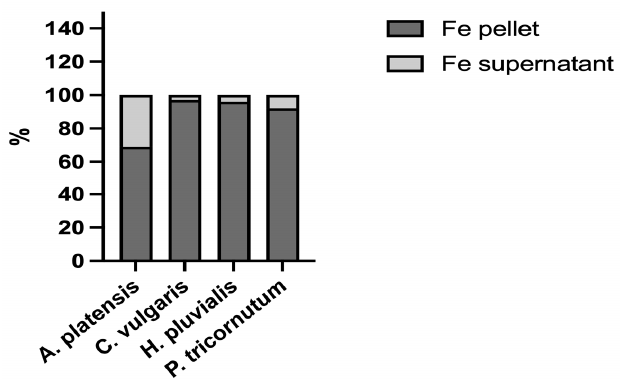
Figure 2. Iron distribution between the supernatants (soluble fractions) and pellets (insoluble frac- tions) obtained after the extraction of A. platensis, C. vulgaris, H. pluvialis, and P. tricornutum. The data are expressed as percentages.